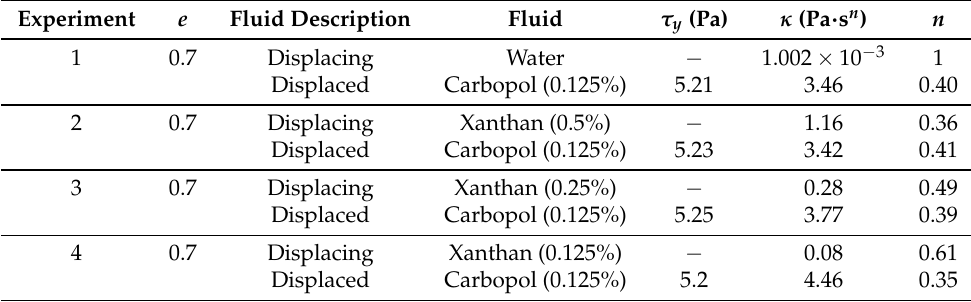
Table 4. Rheological properties of the test fluids.